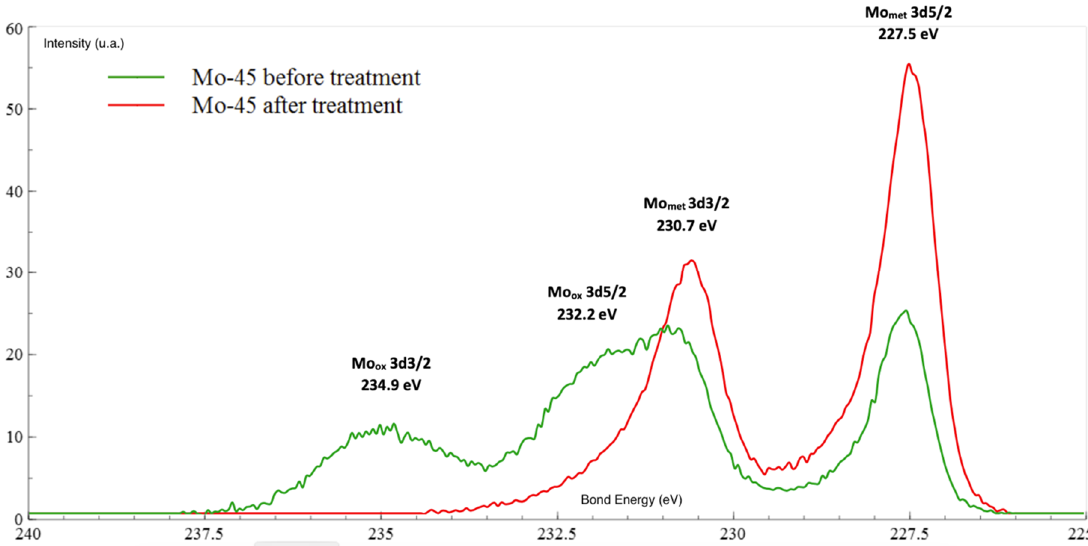
Figure 2. XPS spectra of molybdenum powder before (green) and after (red) thermal treatment performed under vacuum at 800 °C.